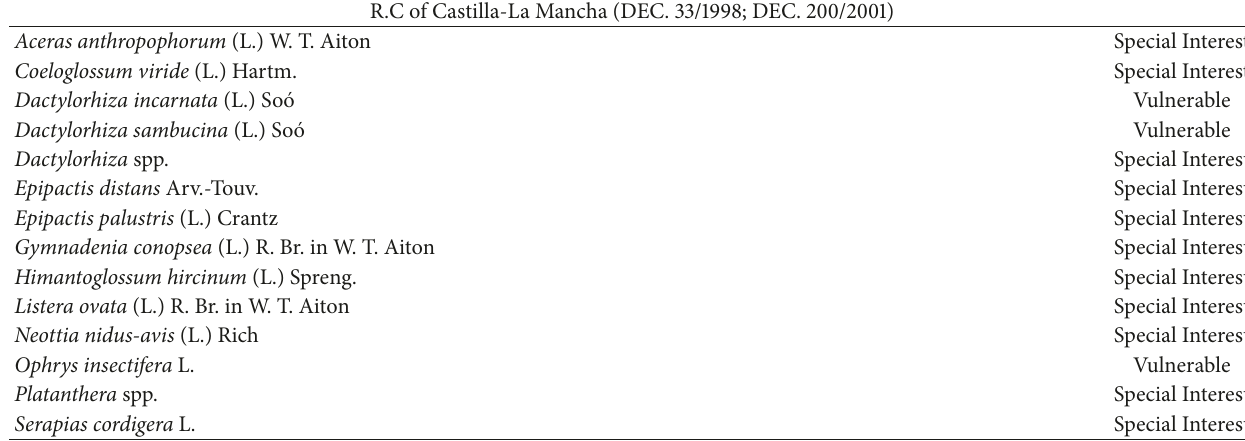
Table 11: Species included in the regional catalogue (R.C.) of Castilla-La Mancha (DEC. 33/1998; DEC. 200/2001). R.C of Castilla-La Mancha (DEC. 33/1998; DEC. 200/2001) Aceras anthropophorum (L.) W. T. Aiton